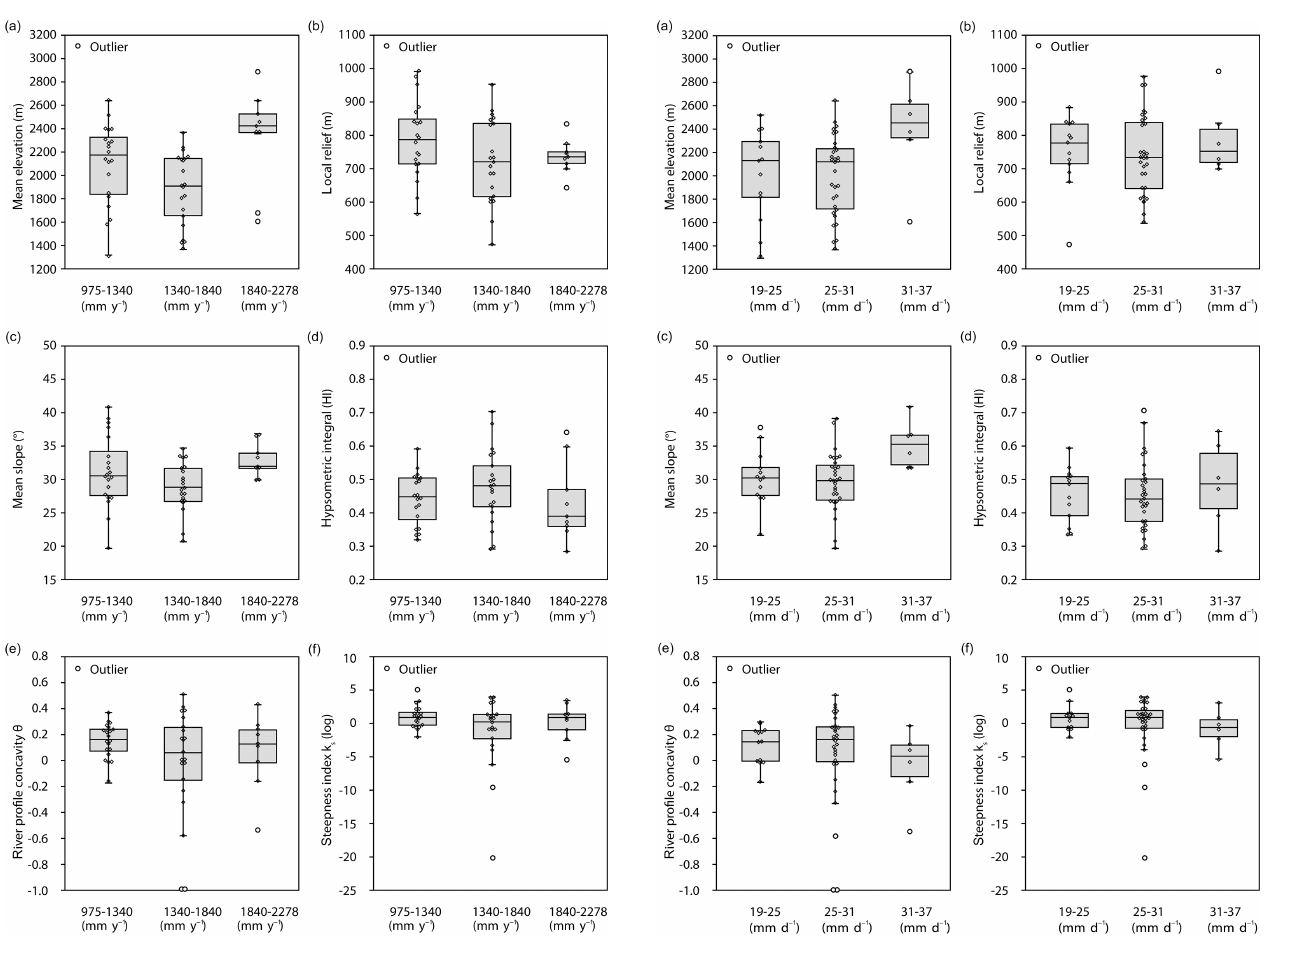
Figure 11. Boxplots of the topographic variables grouped accord- ing to the amount of precipitation, expressed by the annual mean precipitation.